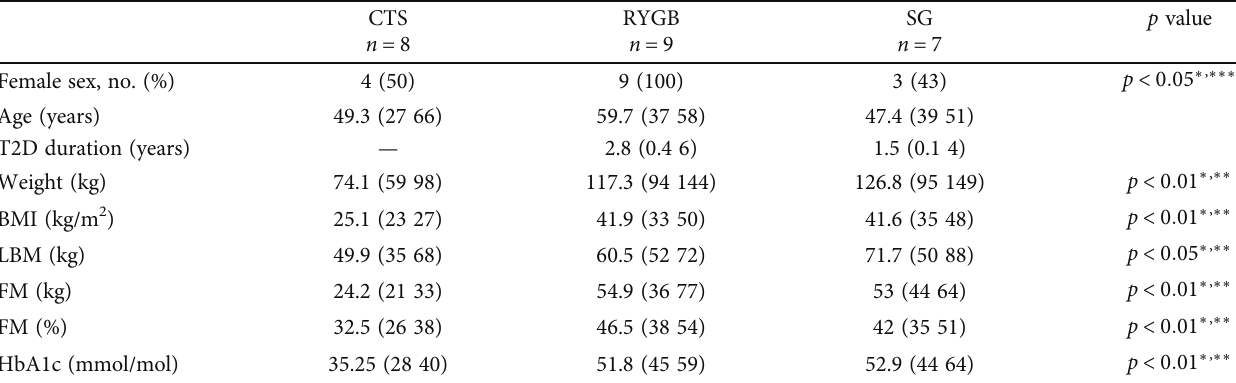
Table 1: Baseline